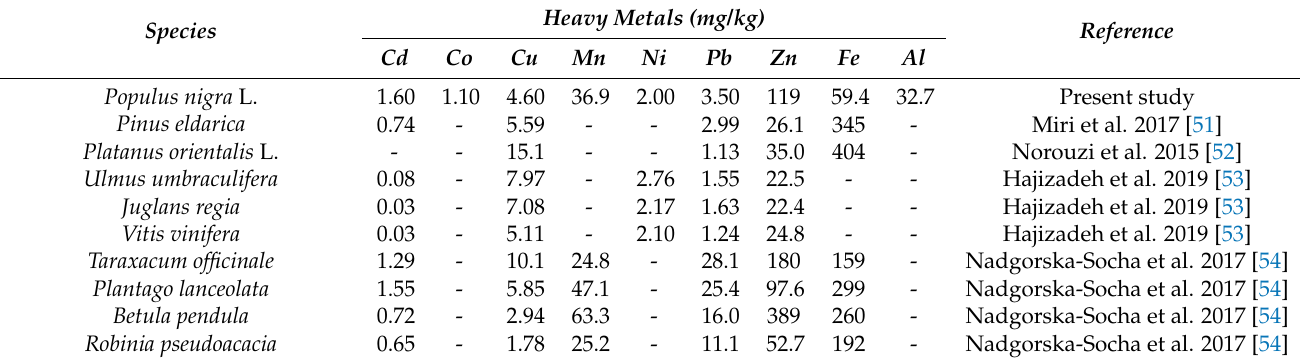
Table 1. Concentration of heavy metals in the leaves of different